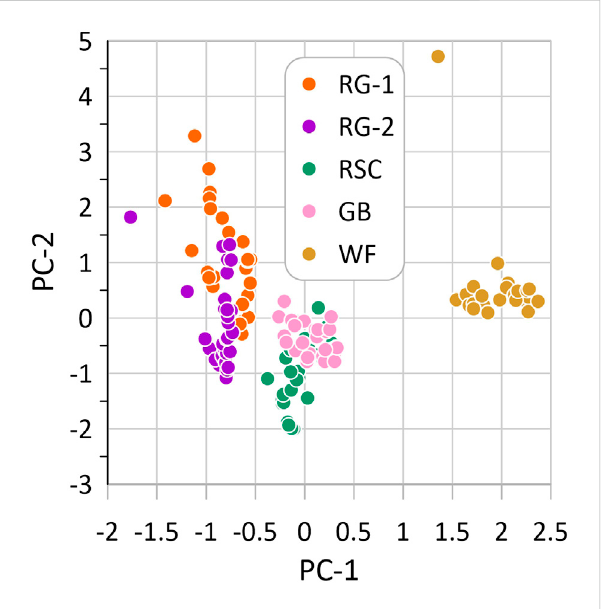
FIGURE 6 Biplot of the fi rst and second principal components determined for thehydrochemicaldata generatedin thisstudy.PC-1 (60.3% ofthe variance) consists of Ca, Mg, Sr, Ti, and Si. PC-2 (14.5%) consists of K, Ba, and